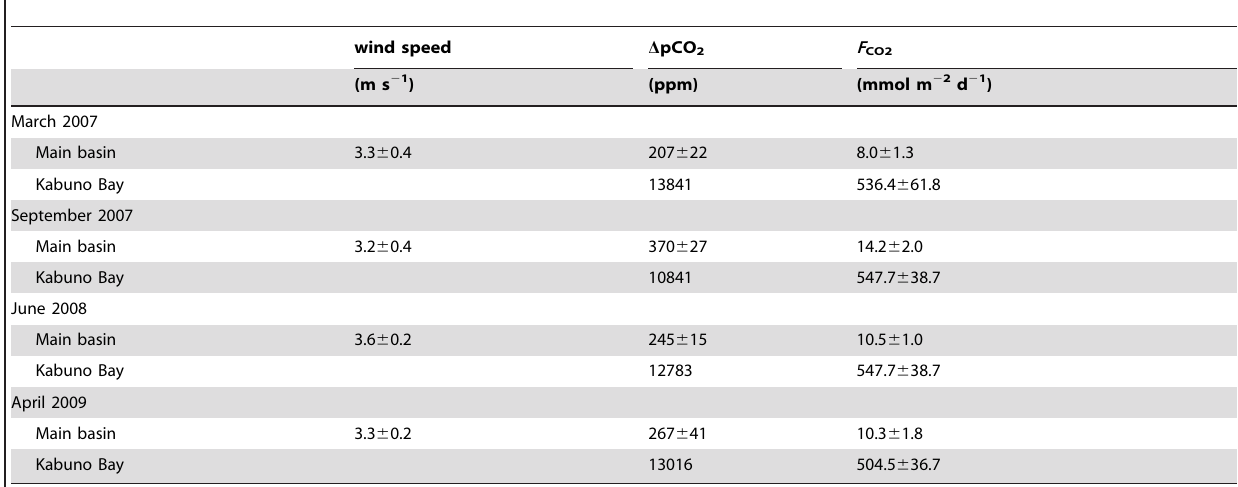
Table 1. Average wind speed (m s 2 1 ), air-water gradient of the partial pressure of CO 2 ( D pCO 2 , ppm), and air-water CO 2 flux ( F CO2